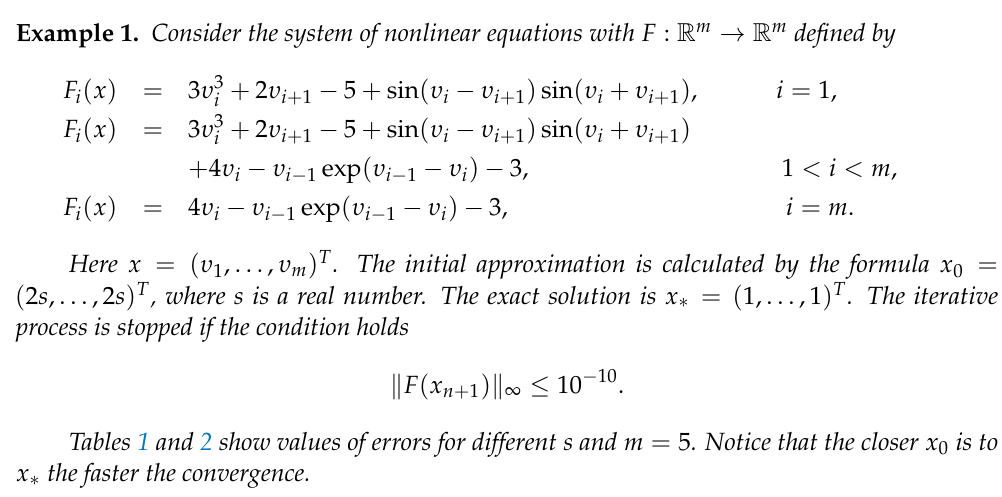
Table 1. The values (cid:107) x n − x ∗ (cid:107) ∞ at each iteration for s = 0.35, 0.4, 0.45. s = n